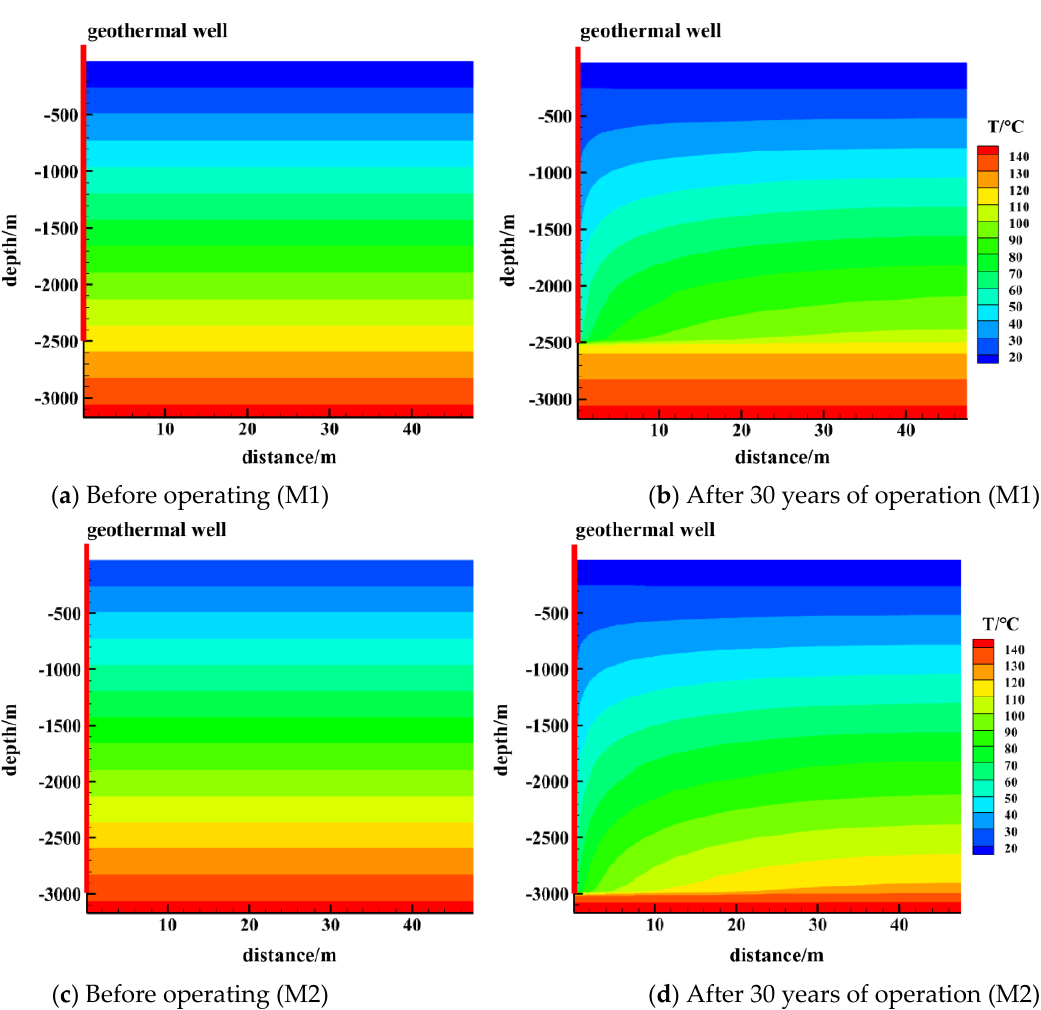
Figure 10. Temperature field diagram of M1 and M2 wells before and after operation at 4.2 °C/hm geothermal gradient.